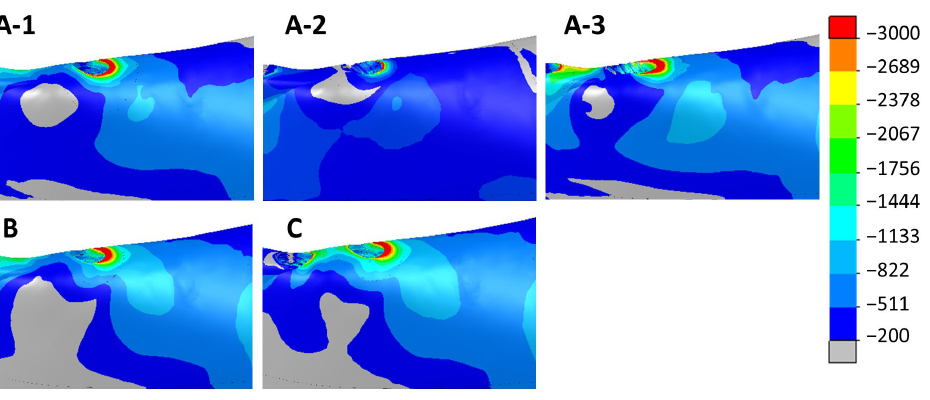
Figure 9. Distribution of the max. principal strain in cases with implants between the foramina. Above—cases with 4 implants (A-1, A-2, and A-3). Below—scenarios with 5 implants (B) and 6 implants (C).